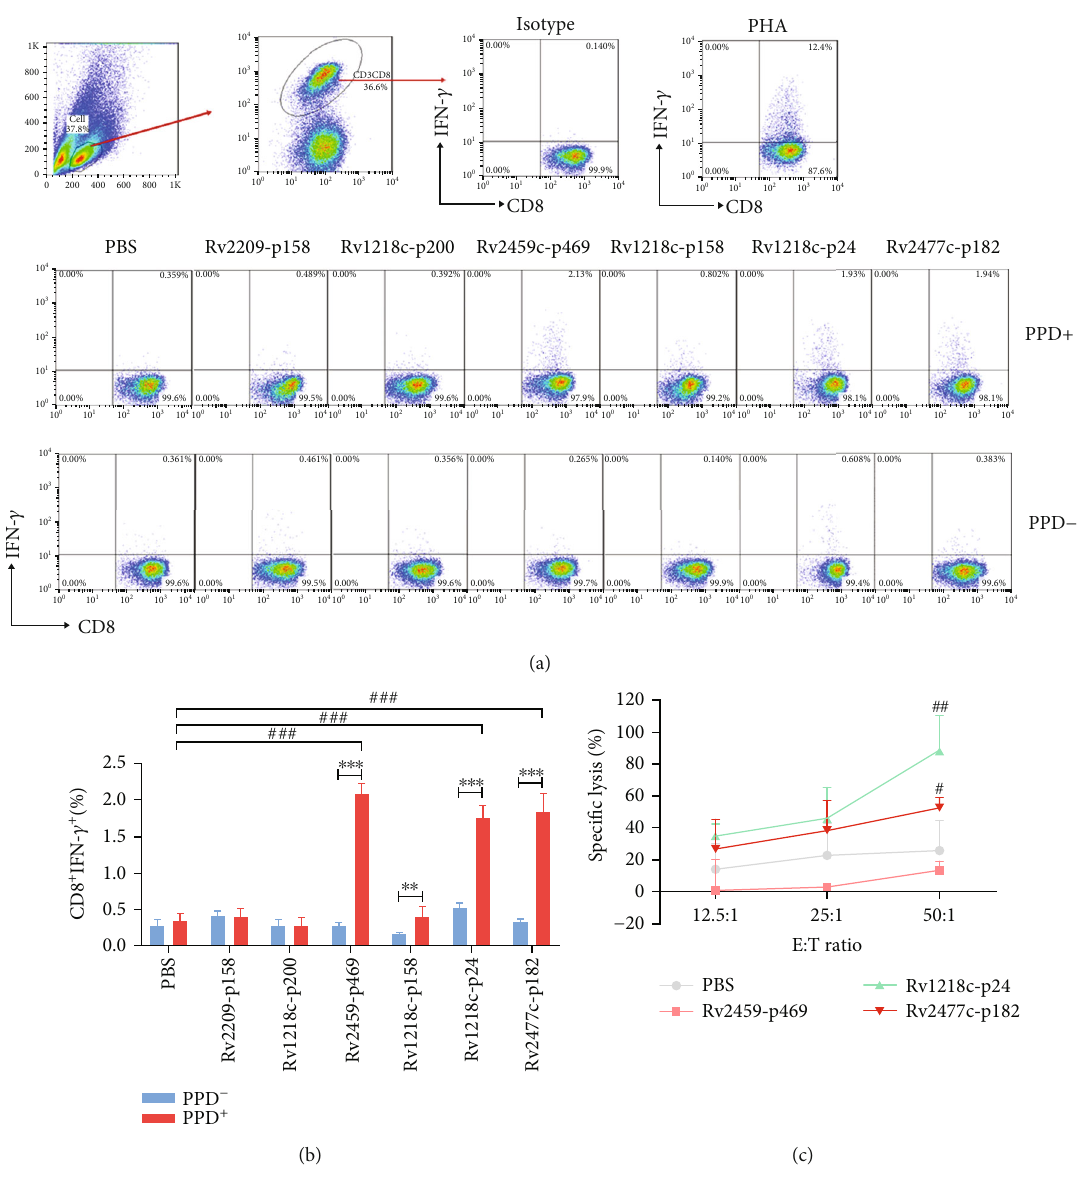
Figure 3: Immune activity of peptide-induced CTLs in vitro was determined with intracellular cytokine staining (ICS) assay and LDH assay. CTLs were induced in vitro with peptide-loaded DCs from three healthy PPD + donors and three PPD - donors. T cells were stimulated three times at weekly intervals, and rhIL-2 (50 U/mL) and rhIL-7 (10 ng/mL) were added at intervals of 2 days. On day 21, the induced T cells were collected and their IFN- γ secretion and lysis activity were measured with intracellular cytokine staining (ICS) and LDH assays. (a) Typical fl ow chart for each group of PPD + and PPD - donors. (b) Statistical results of ICS assay for each peptide ( n = 3 ). (c) LDH assay ( n = 4 ). Peptide-loaded T2A2 cells were used as the stimulated cells and target cells. PBS group was the negative control; PHA was used as the positive control. Statistical signi fi cance was determined with Student ’ s t -test. ∗ P < 0 : 05 , ∗∗ P < 0 : 01 , and ∗∗∗ P < 0 : 001 represent the signi fi cance of the di ff erences between the PPD + donors and PPD - donors. # P < 0 : 05 , ## P < 0 : 01 , and ### P < 0 : 001 represent the signi fi cance of the di ff erences between the peptide-treated groups and the PBS